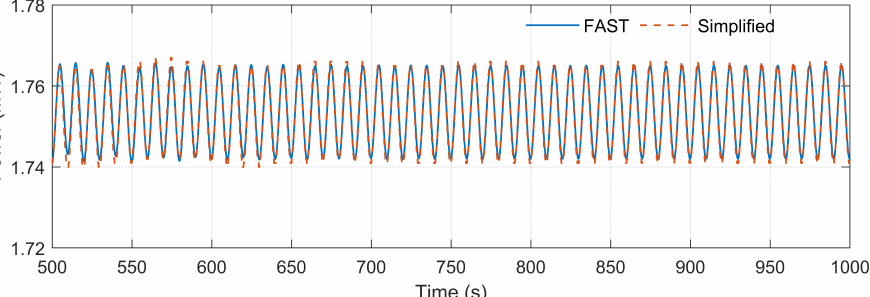
Figure 10. Output power of the semi-submersible floating turbine under regular wave and wind speed of 8 m/s.